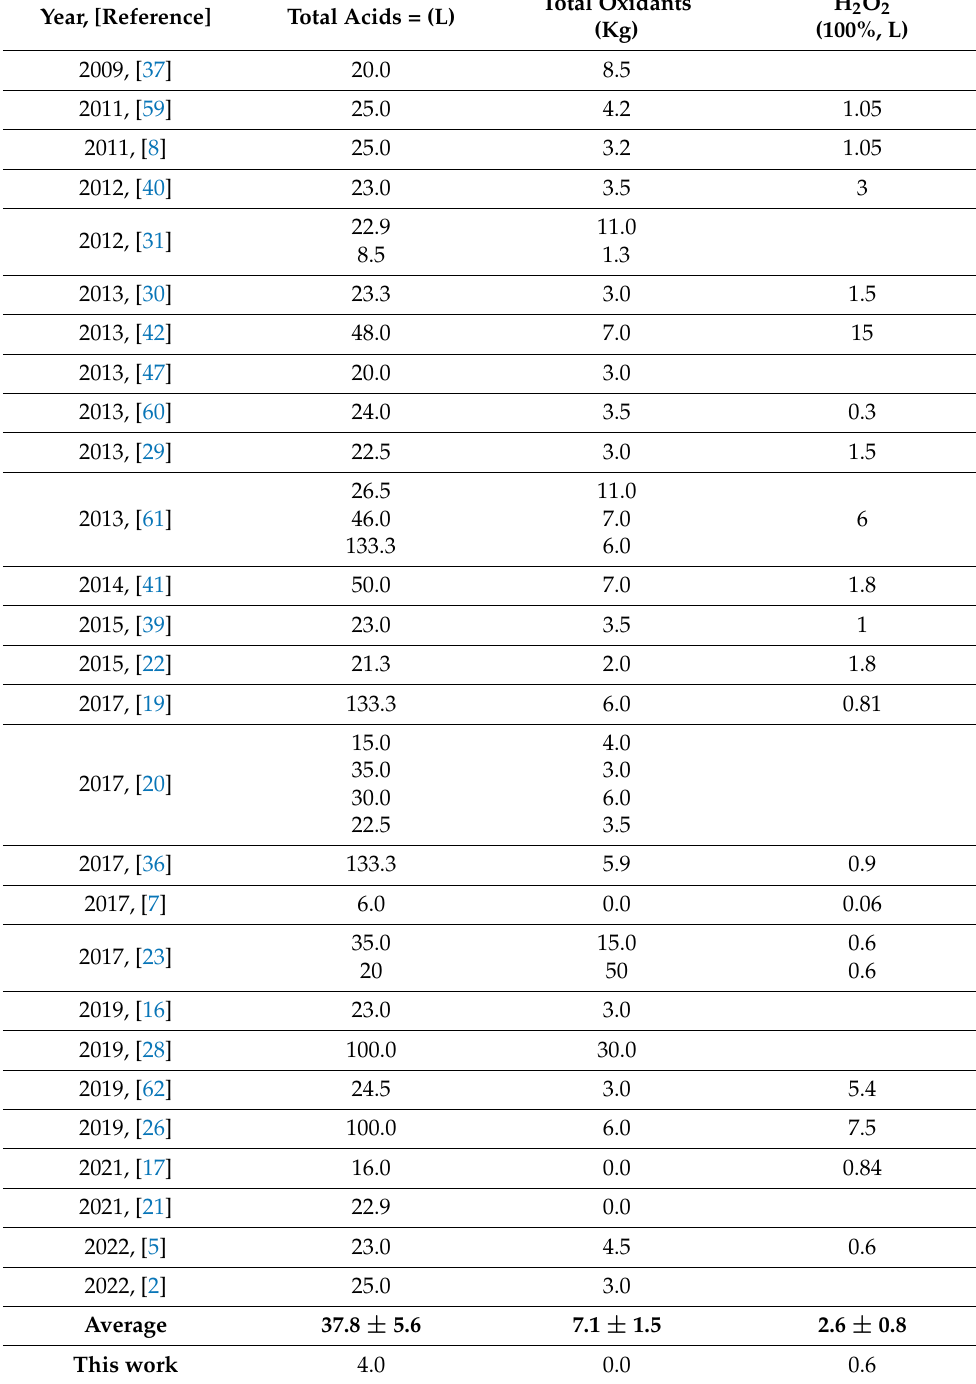
Table 1. Summary chart with the type of chemical and amount used to process one Kg of raw graphite, based on the description of each reference, noticed that H 2 O 2 was only used to eliminate permanganate residues, not as a formal